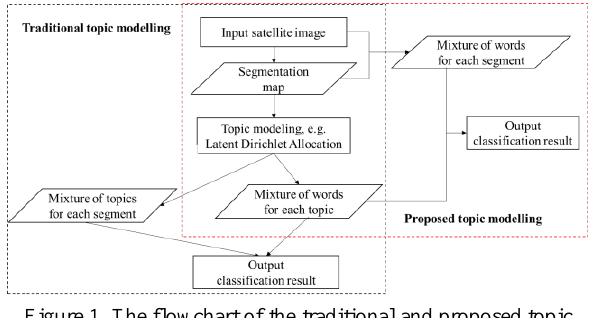
Figure 1. The flowchart of the traditional and proposed topic modelling algorithms for the satellite image classification